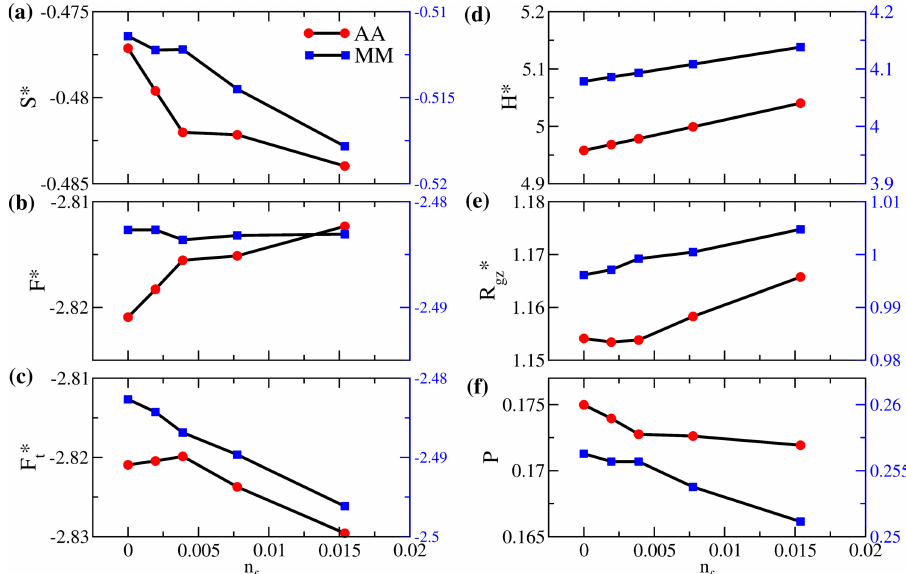
Figure 7. ( a ) Scaled entropy per bead ( S ∗ ), ( b ) scaled free energy per bead for polymer brushes ( F ∗ ), ( c ) scaled total free energy per bead ( F ∗ t ), ( d ) scaled gap thickness ( H ∗ ), ( e ) degree of interpenetration of polymers ( P ), and ( f ) ratio of the z -component actual gyration radius to the reference gyration radius ( R ∗ gz ) as a function of the number fraction of free particles ( n f ) for brushes AA (red circles; left axis) and MM (blue squares; right axis). The two vertical axes are fixed at the same range of